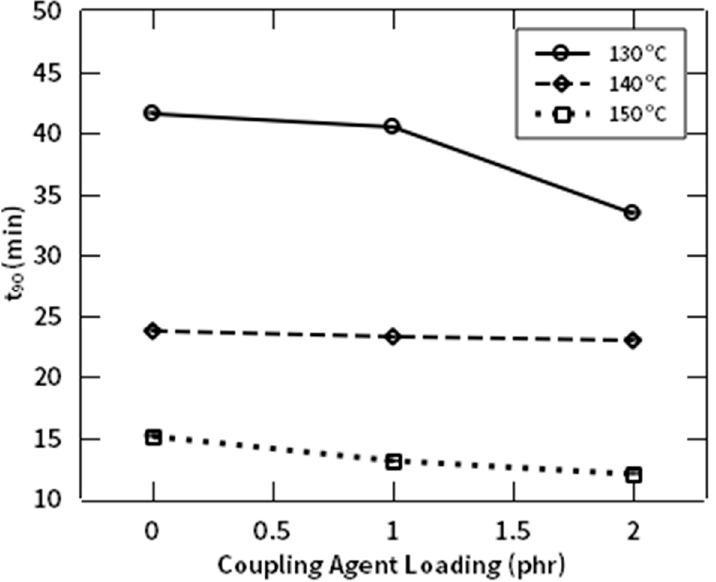
ff erent composition of Figure 12. t 90 profile of NR compound at different composition of NR-g-St. Figure 12. t 90 profile of NR compound at di Figure 12. t 90 profile of NR compound at different composition of NR-g-St.